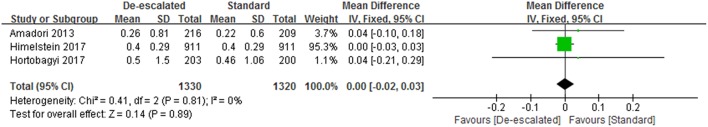
Meta-analysis result of SMR.